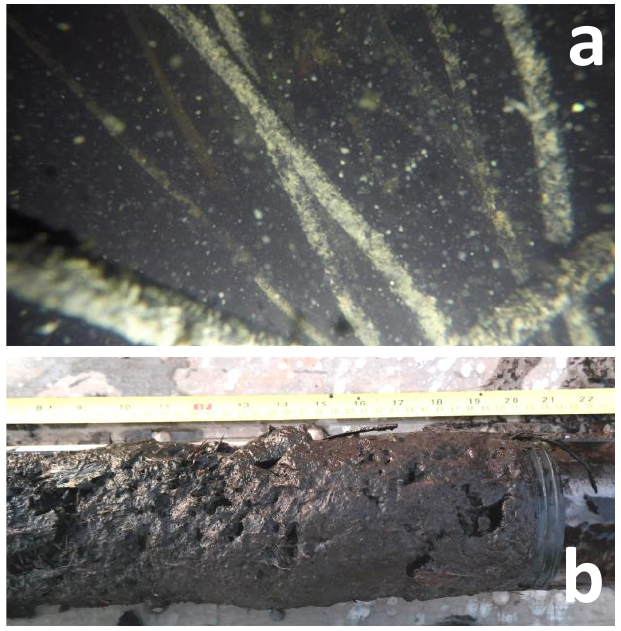
Figure 24. ( a ) . Image from vegetation in the Passaúna reservoir bottom; ( b ) . Sediment core from Passaúna Reservoir.